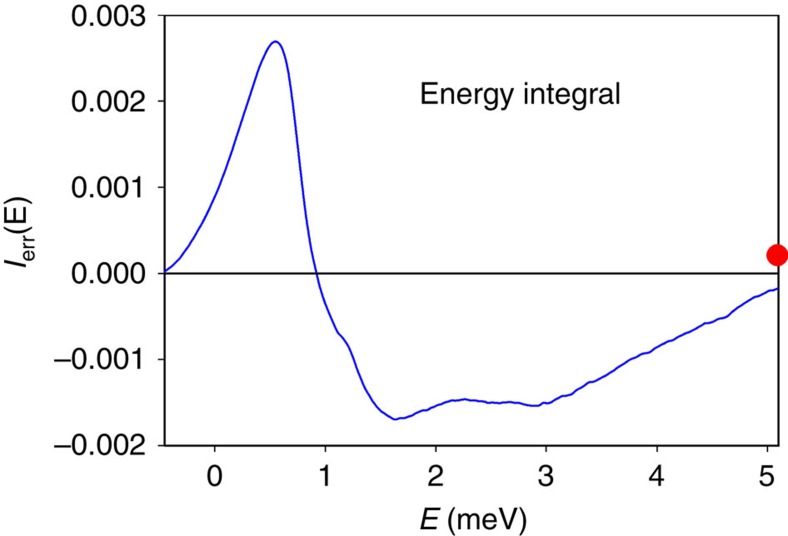
The integrated DPDF as a function of energy.The integral, Ierr(E) in equation (4), varies strongly with E, but converges to a small value at large E. The red dot indicates the value of Ierr(E) at the highest value of E in the present measurement, 27 meV.